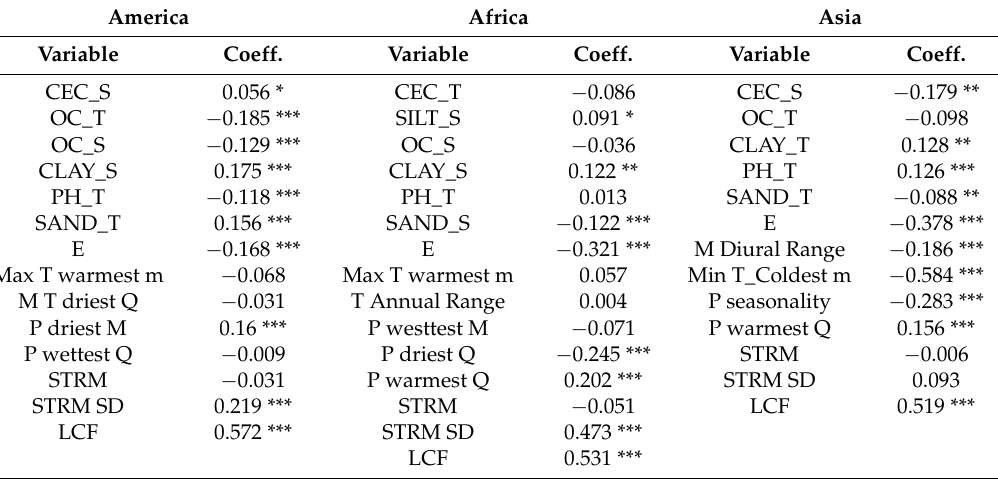
Table 3. Spatial regression results using SEVM method for TCH 90